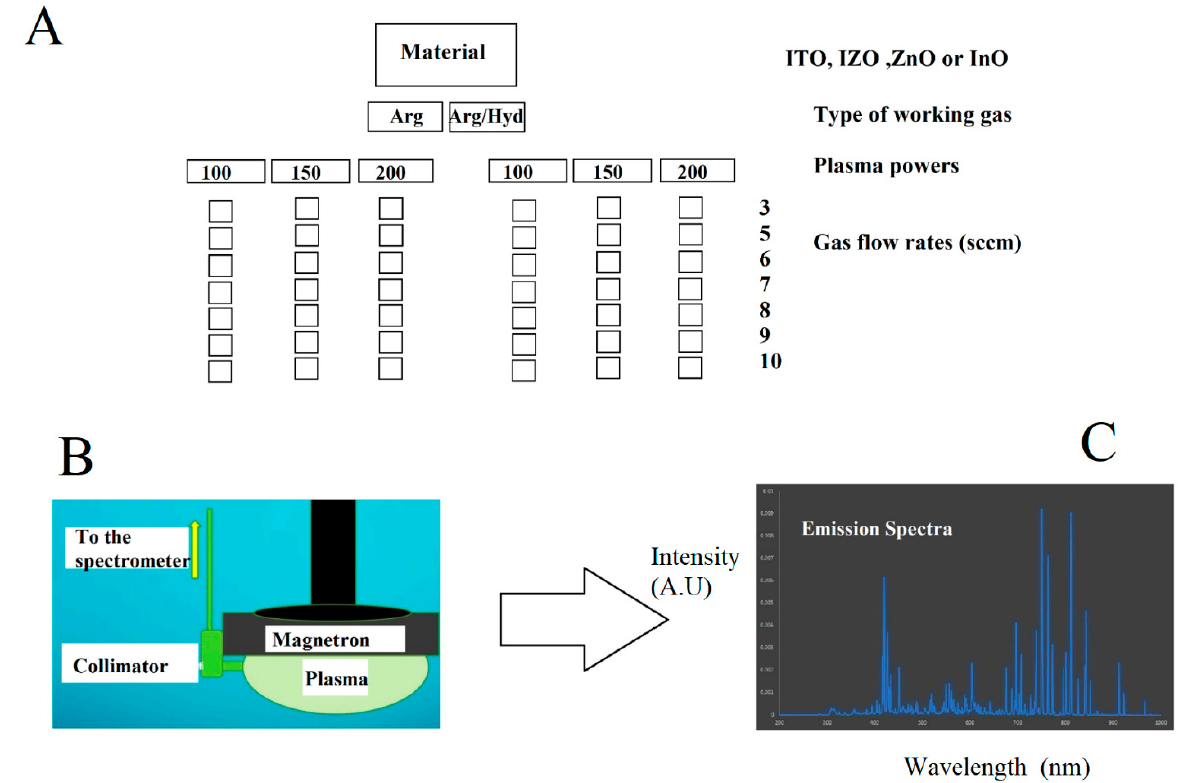
Figure 5. ( A ) By fitting the seven targets separately, plasma was generated under both pure argon and argon containing hydrogen. The plasma was generated using 100, 150, and 200 watts of RF power and data were collected under gas-flow rates of 3, 5, 6, 7, 8, 9, and 10 square cubic centimeters (sccm). ( B ) The spectral data were collected via a collimator fitted next to the magnetron. ( C ) At each single point, spectral data were collected, to have a collection of spectral data associated with plasma operating conditions. Overall, a total of 588 spectral data plots were selected for deep-learning studies.